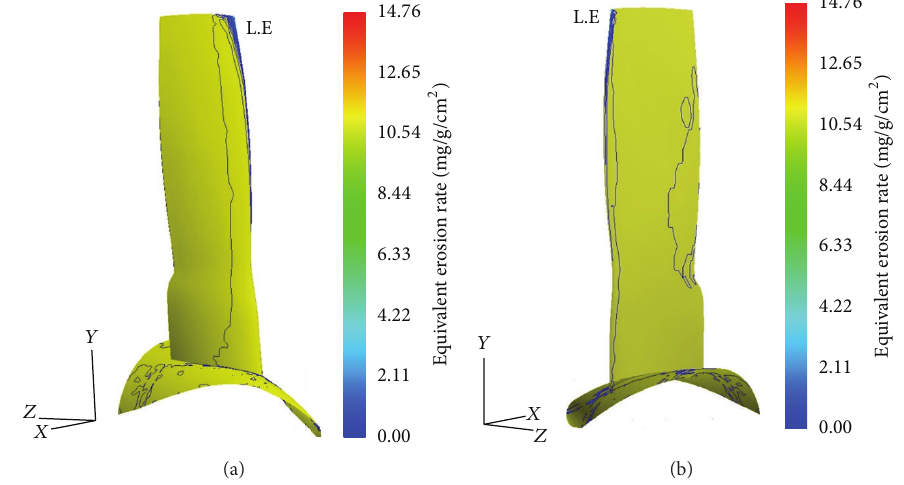
Figure 12: Equivalent erosion rates (mg/g/cm 2 ) at low concentration (10mg/m 3 ): (a) Suction side and (b) pressure side.